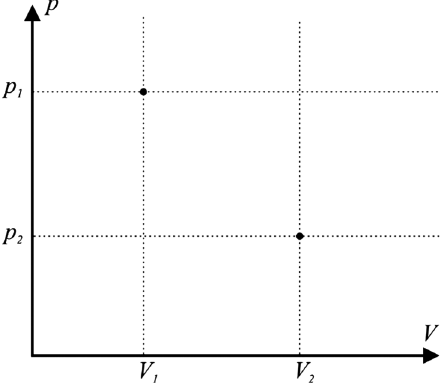
FIG. 2. A pV diagram for the pre-testing task